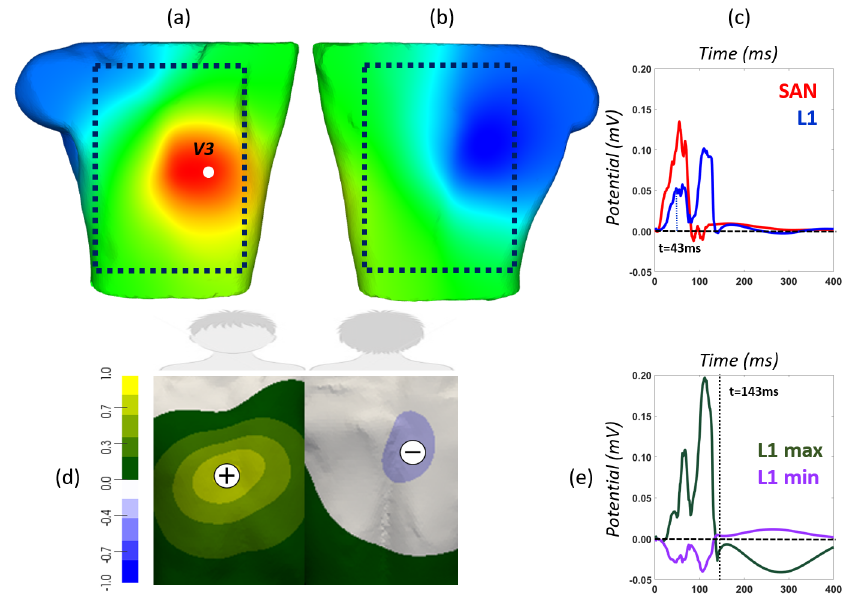
Fig 2. Simulated BSPMs and integral map (BSPiM) computed at the torso surface. Torso model (includingthe atria and the additionalregions)showingan exampleof the frontal (a) and rear (b) views of the Body Surface Potential Map (BSPM) at time t = 43 ms, applyingthe ectopic beat at position L1. The dotted squarerepresents the approximate area of the frontal and rear surface where electrographic signals may provide useful information; (c) morphologyof the P-wave (potentialversus time) registeredat the precordial lead V3 (highlightedas a white spherein (a) in sinus rhythm (red line) and when stimulatingectopic L1 (blue line); d) Characteristic P-wave integralmap (BSPiM) (left). Greenishto yellowisharea representspositive P- waves registeredat any lead of this area (see green P-wave line in panel (e) registeredat the positionwith maximum integralvalue), and greyishto blueishregion means negativeP-waves (see purpleP-wave line in panel (e) registeredat the position with the minimum integralvalue); e) Dashed horizontalbaselinerepresents the divisionbetweenpositive and negativepotentials. Dotted vertical line definesthe durationof the P-wave definedas the latest atrial depolarization time for each simulation(t = 143 ms in the case of L1).